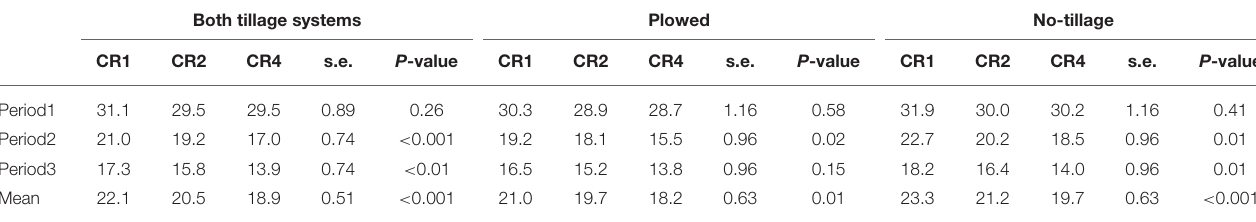
TABLE 7 | The average stem and root disease index (0–100) in spring wheat in different tillage systems, time periods, and crop rotations. Both tillage systems Plowed